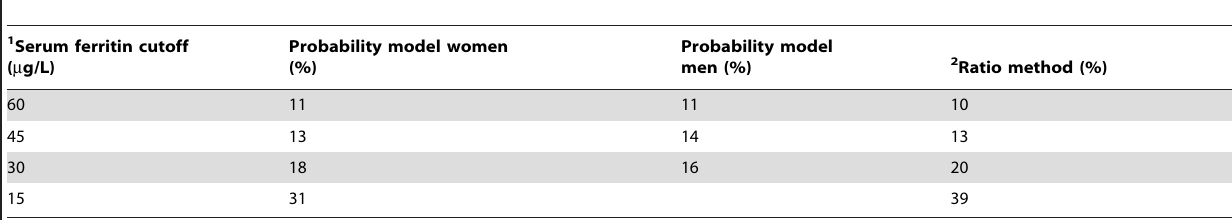
Table 2. Estimated dietary iron absorption for selected serum ferritin values in men and